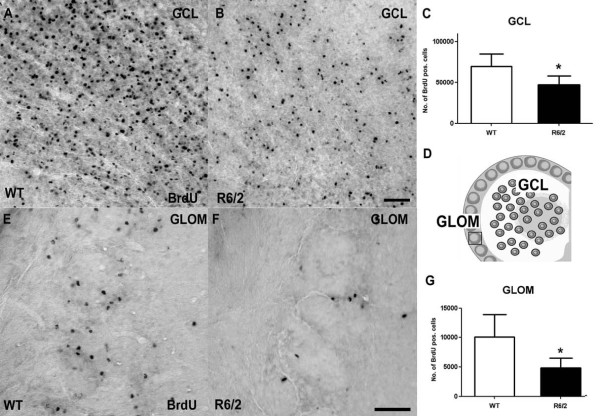
Impaired survival of newly generated cells in the two neurogenic regions of the olfactory bulb in HD mice compared to controls. Significant reduction of BrdU-labeled newly generated cells in the GCL and the GLOM 4 weeks after BrdU administration in R6/2 mice compared to controls (C, G). Representative images of immunostainings for BrdU in the GCL (A, B) and the GLOM (E, F) of both groups. Schematic representation of the OB areas analyzed (D). Error bars represent SD, * indicates p < 0.05. Scale bars represent 50 μm.